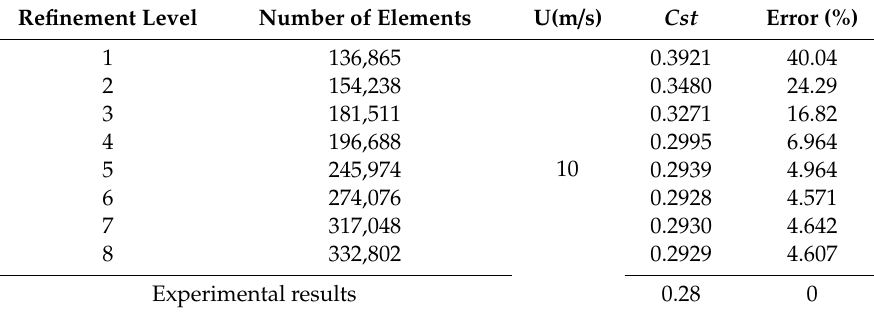
Table 3. Grid independence test.